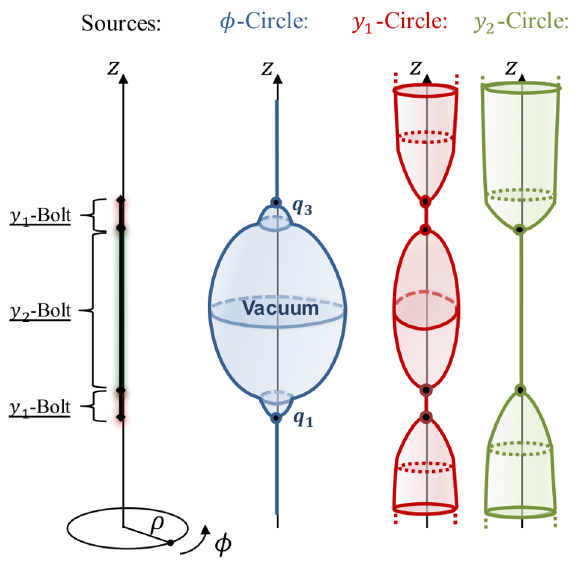
Figure 3 . Schematic description of the smooth three-bubble configuration and the behavior of the φ , y 1 and y 2 circles on the z